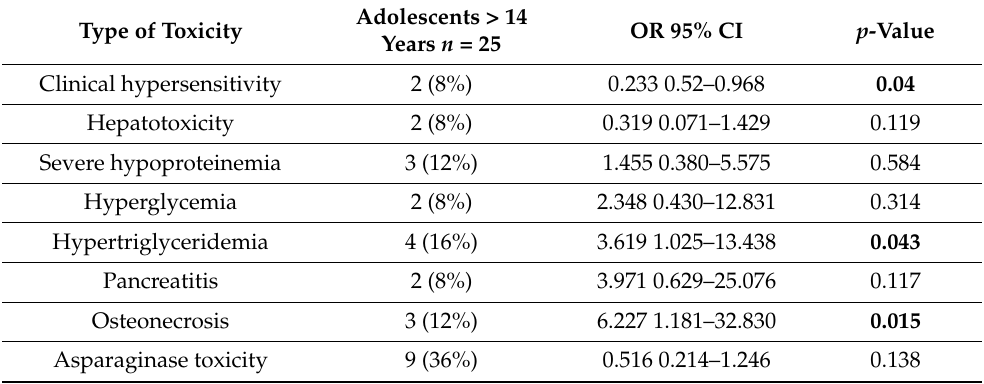
Table 2. Incidence of L-asparaginase-associated toxicity in adolescents >14 years.